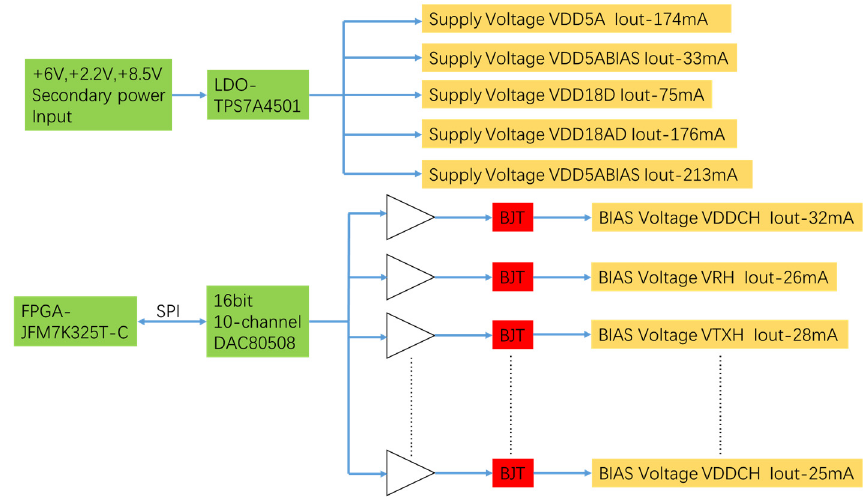
Figure 6. Low-noise power supply and low-noise bias block diagram of CMOS detector.